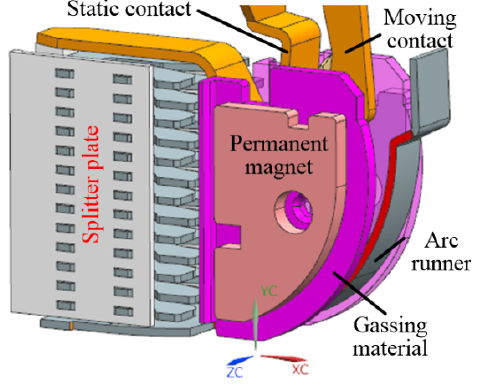
Figure 1. Layout scheme of arc extinguishing chamber.